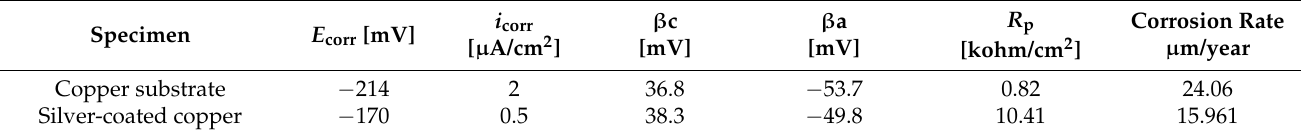
Table 1. Polarization